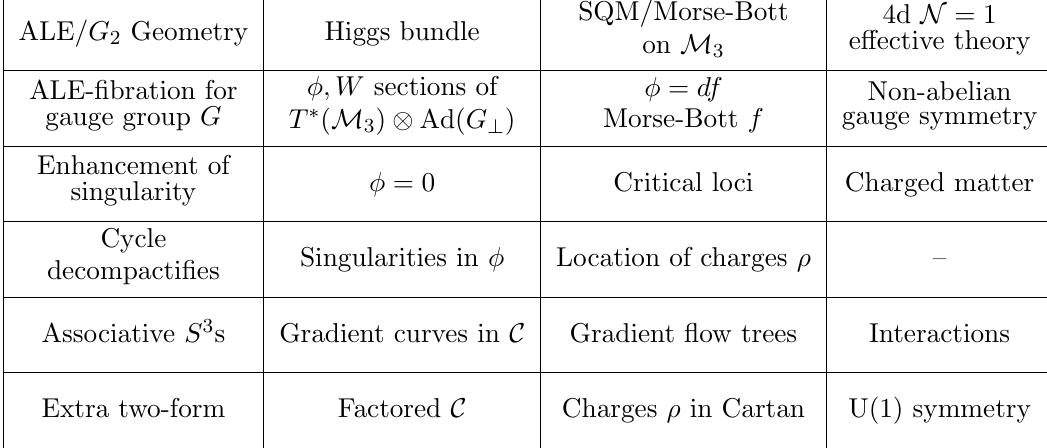
construction of the three-cycles in the ALE-(cid:12)bration, and determines the matter (cid:12)elds and couplings in